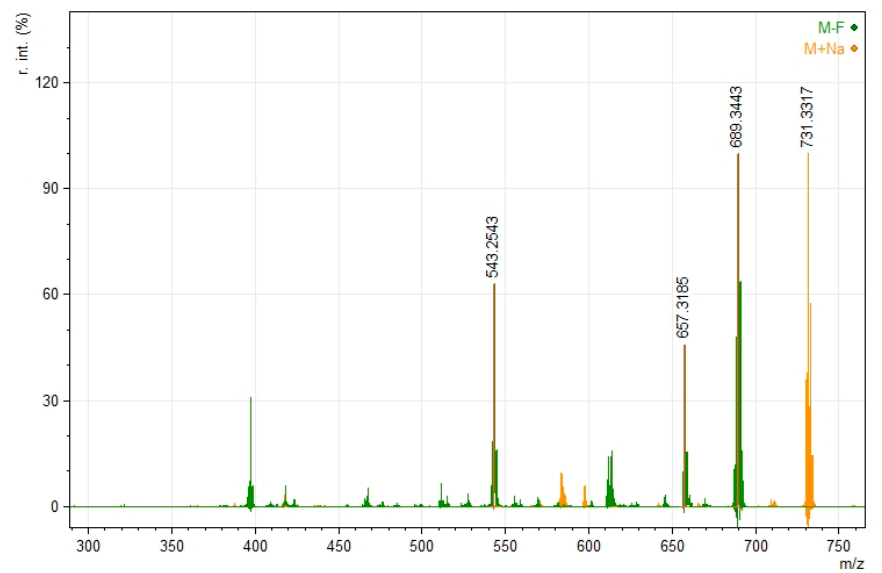
Figure 4. Mass spectrum of compound 4 with the presentation of fragmentations; [M+Na] + sodium adduct with molecular ion in yellow, and [M-F] + molecular ion without fluorine anion in